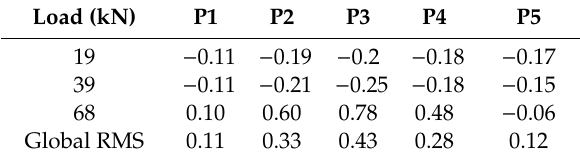
Table 5. DPA-LT (mm)